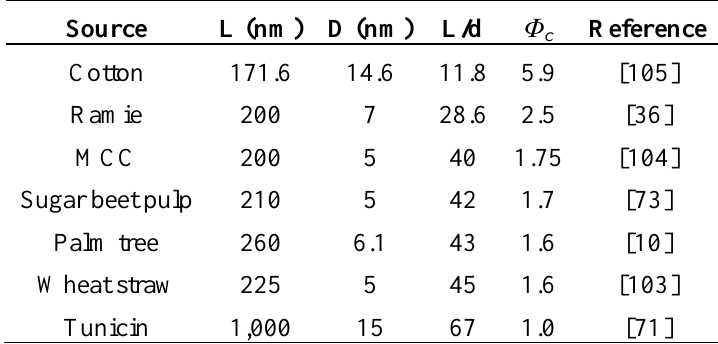
Table 4. Geometrical characteristics (length, L, and diameter, D) and percolation threshold (Φ ) of some cellulose c